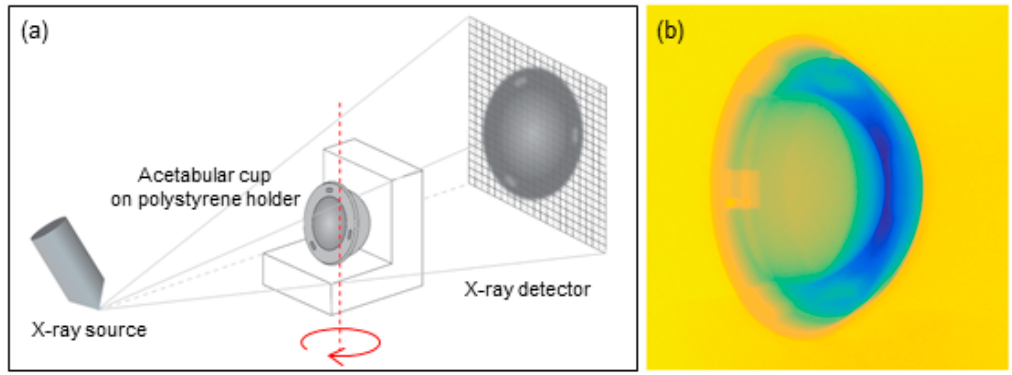
Figure 3. ( a ) Acetabular cup as it was positioned during the CT acquisition; ( b ) example of 2D projection image acquired by CT (RGB coded), showing that the polystyrene stand is not visible and does not disturb the measurement.